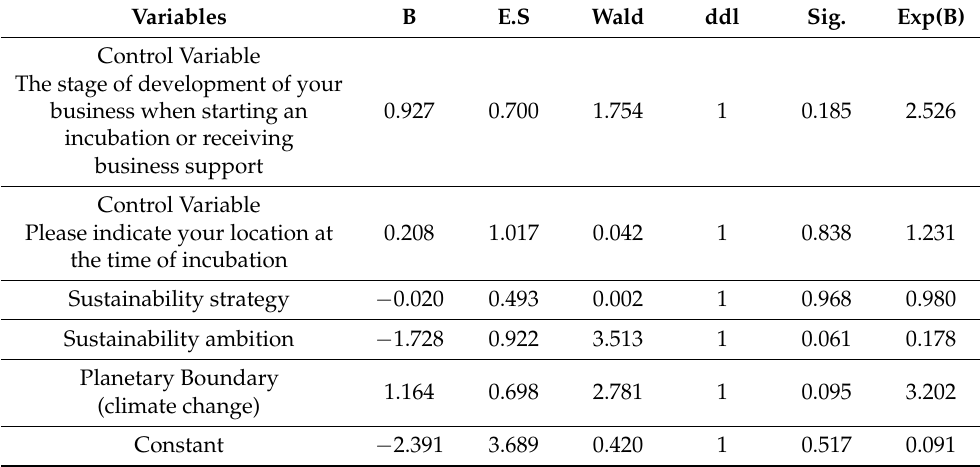
Table 7. Summary of results on the determinants of technology-driven sustainable value creation (source: authors’